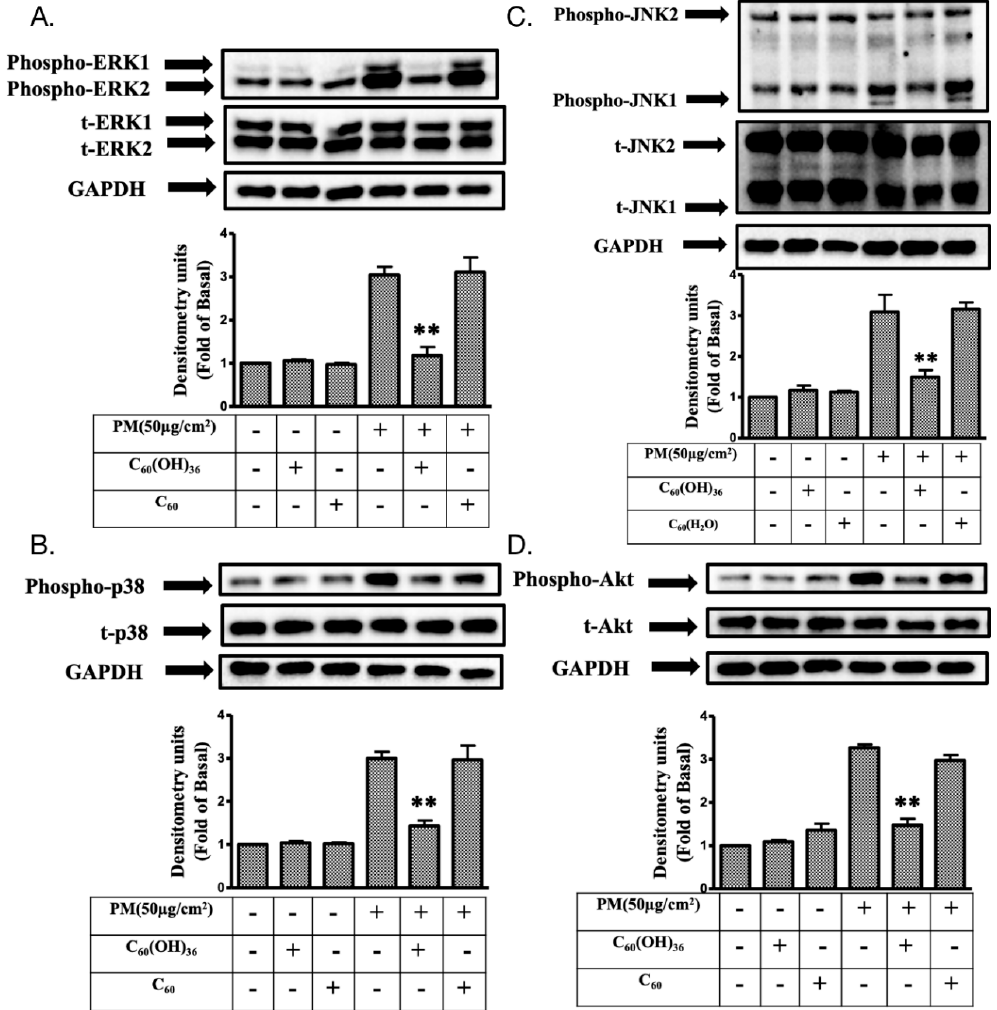
Figure 6. The changes in phosphorylated MAPK and Akt protein levels in fullerenol C 60 (OH) 36 and PM-treated HaCaT cells. The expression levels of different kinases, including ( A ) extracellular signal-regulated kinase (ERK, p42 / p44), ( B ) P38, ( C ) c-Jun N-terminal kinase (JNK), and ( D ) Akt were measured by immunoblotting in the HaCaT cells with or without providing pre-treatment with 1 μ M of fullerenol C 60 (OH) 36 or fullerene C 60 for 1 h and with PM (SRM 1649b, 50 µ g / cm 2 ) for another 6 h. Glyceraldehyde 3-phosphate dehydrogenase (GAPDH) was used as a loading control. Blots were representative of three independent experiments, and the data were expressed as mean ± SEM values. ** p < 0.01, as compared to the values for the PM exposure group.